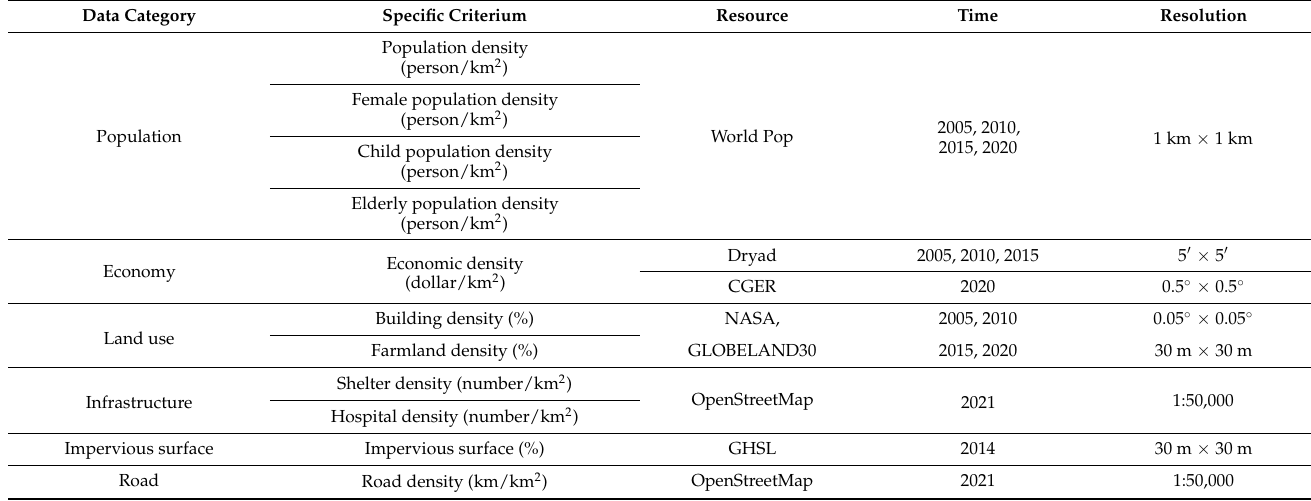
Table 3. Flood vulnerability data categories and resources.